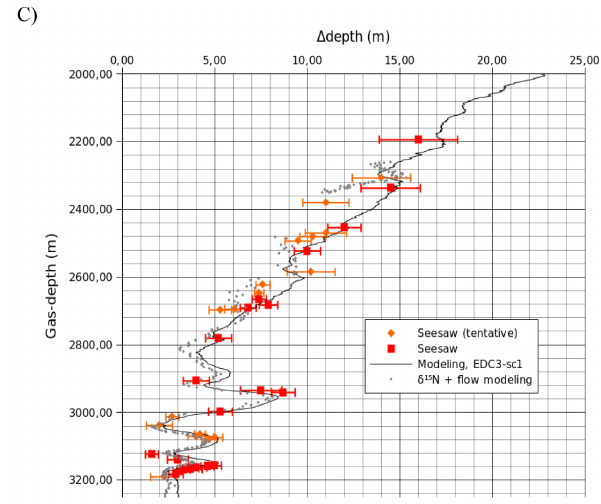
Fig. 8. (C) Zoom on the 2000–3200m depth